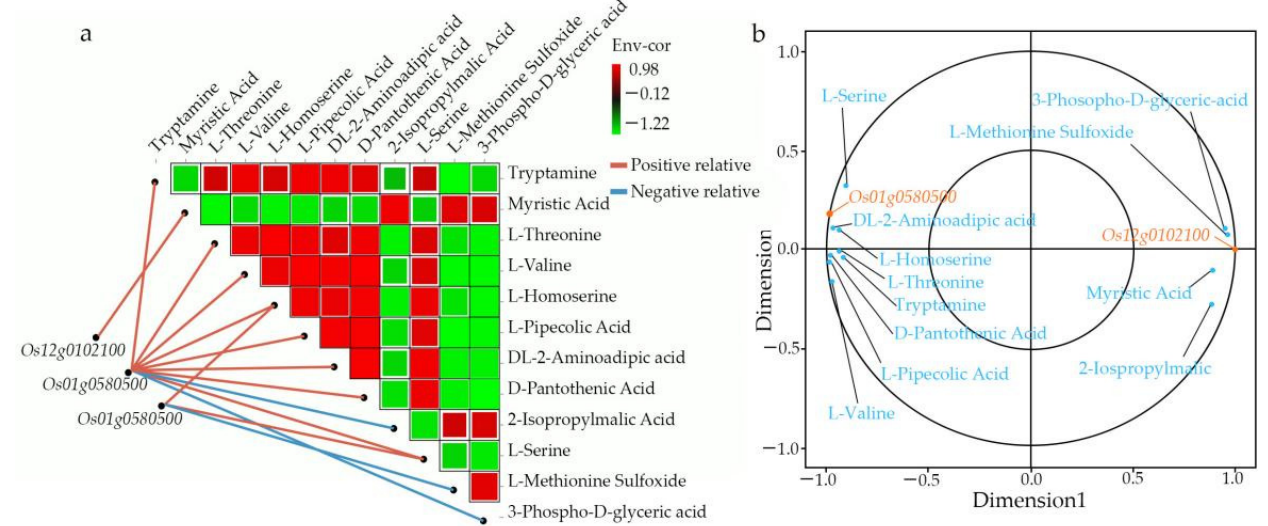
Figure 13. The co-expression analysis of DEGs and DEMs is based on Pearson correlation. Pearson correlation coefficient > 0.8 or ≤ − 0.8, p -value ≤ 0.05. ( a ), Dynamic network heat map of metabolites and genes; the horizontal and vertical axes represent DEMs, and the red or green color in each square of the heat map indicates the positive or negative correlation coefficient between DEMs; DEGs are shown on the left side, and these genes are correlated with differentially expressed metabolites one by one by connecting lines. The blue and orange lines indicate the degree of significance. ( b ), Canonical correlation analysis (CCA) of metabolites and genes.